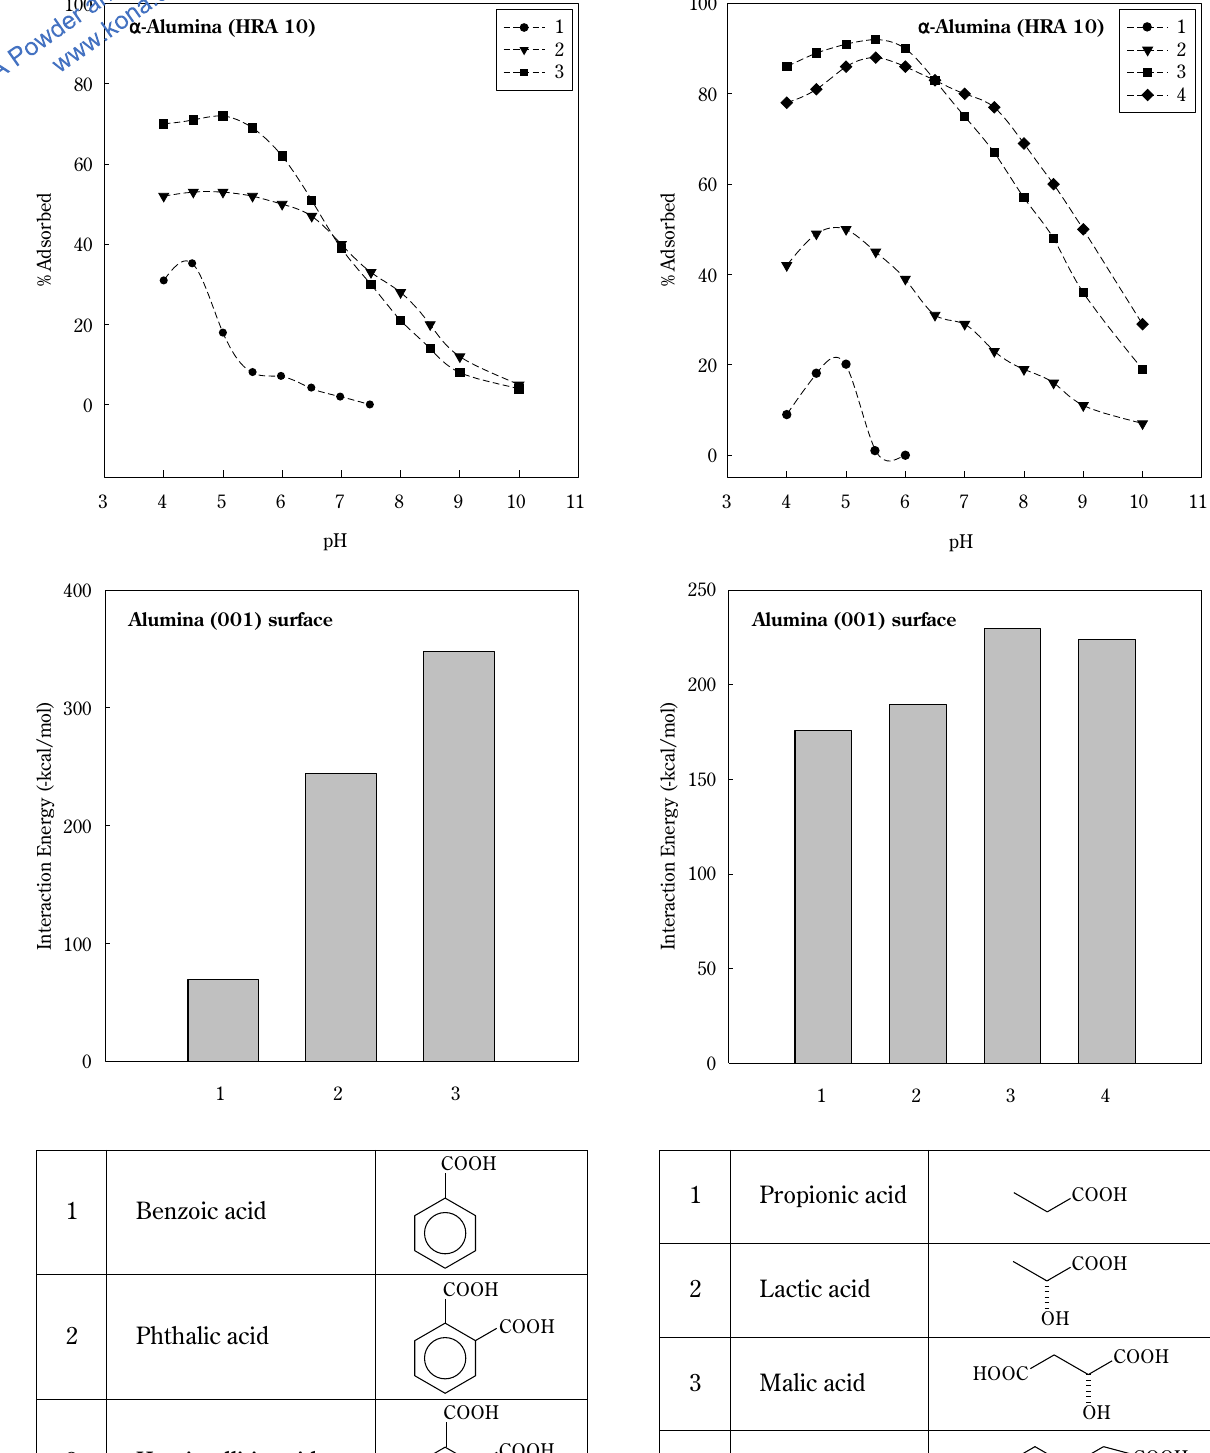
Fig. 4 (a) Adsorption curves for aromatic carboxylic acids on α - alumina (data taken from Ref. [45]), (b) Theoretically computed interaction energies obtained using MD simula- tions in presence of water.